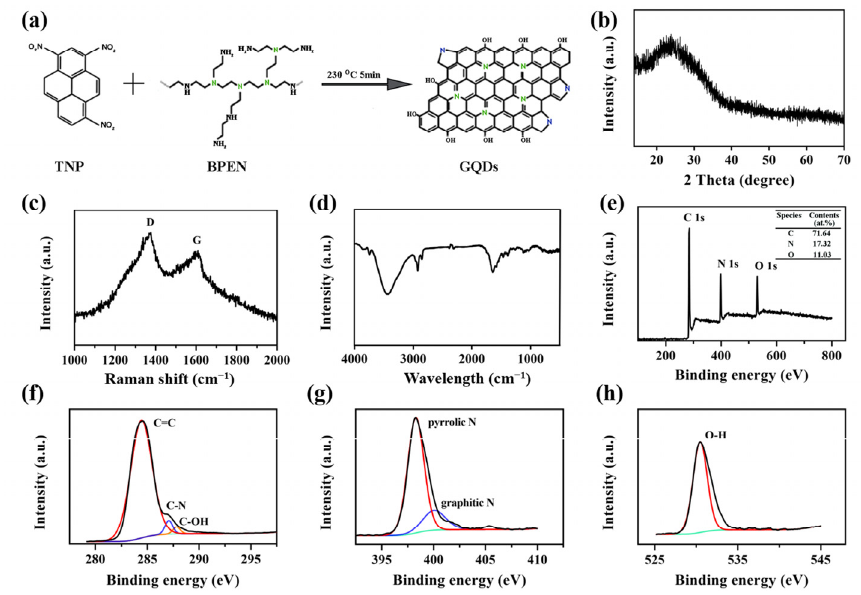
Figure 1. Characterization of GQDs. ( a ) Schematic diagram of the GQDs synthesis pathway. ( b ) XRD pattern of GQDs. ( c ) Raman spectrum of GQDs. ( d ) FTIR spectra of GQDs. ( e ) Survey XPS spectrum. ( f ) High-resolution C1s spectrum. ( g ) High-resolution N1s spectrum. ( h ) High-resolution O1s spec- trum.